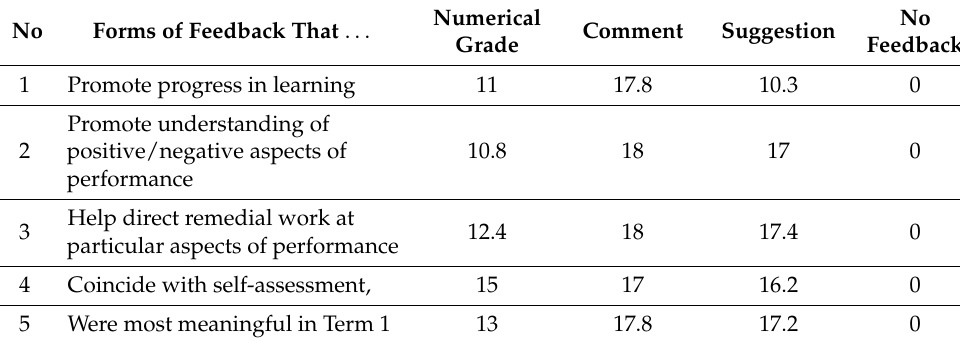
Table 1. Analysis of students’ feedback received in the GE course. Forms of Feedback That . .